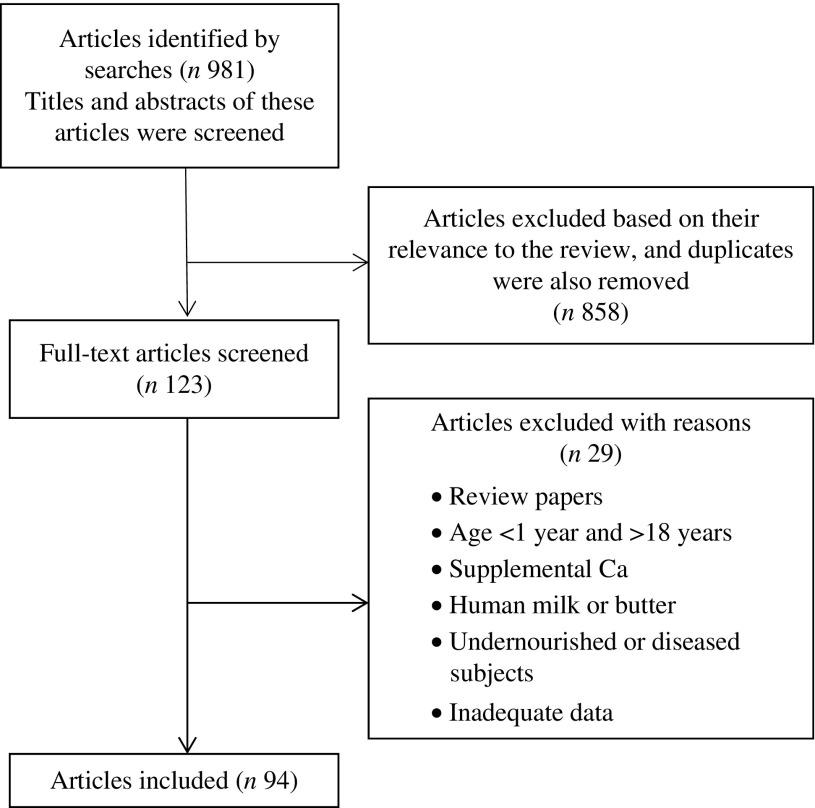
Flow diagram for the selection of eligible studies.